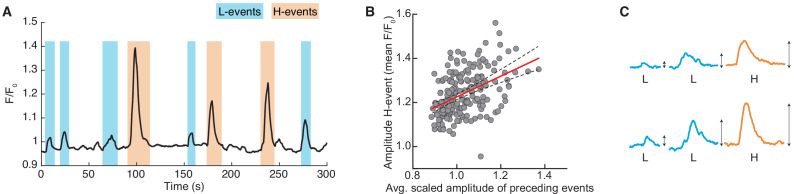
Spontaneous events in developing cortex adapt to recent activity.(A) Calcium trace of a representative recording with L- (blue) and H-events (orange) (Siegel et al., 2012). (B) The amplitude of an H-event shown as a function of the aggregate amplitude of preceding L- and H-events up to Tmax=300 s before it, scaled by an exponential kernel with a decay time constant of 1000 s (N=195 events from nine animals). Animals with fewer than 12 H-events preceded by activity within Tmax were excluded from this analysis (see Materials and methods). The Pearson correlation coefficient is r=0.44,p<10−10, CI =(0.32,0.54). Red line indicates regression line with 95% confidence bounds as dashed lines. (C) Schematic of the postulated adaptation: A weak (strong) H-event is more likely to be preceded by weak (strong) spontaneous events.